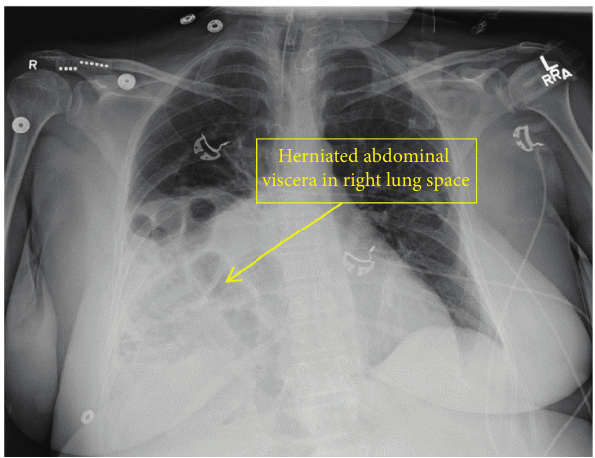
Figure 2: Chest X-ray revealing large right Morgagni hernia containing fat and several loops of small bowel. Associated right lung volume loss and atelectasis.